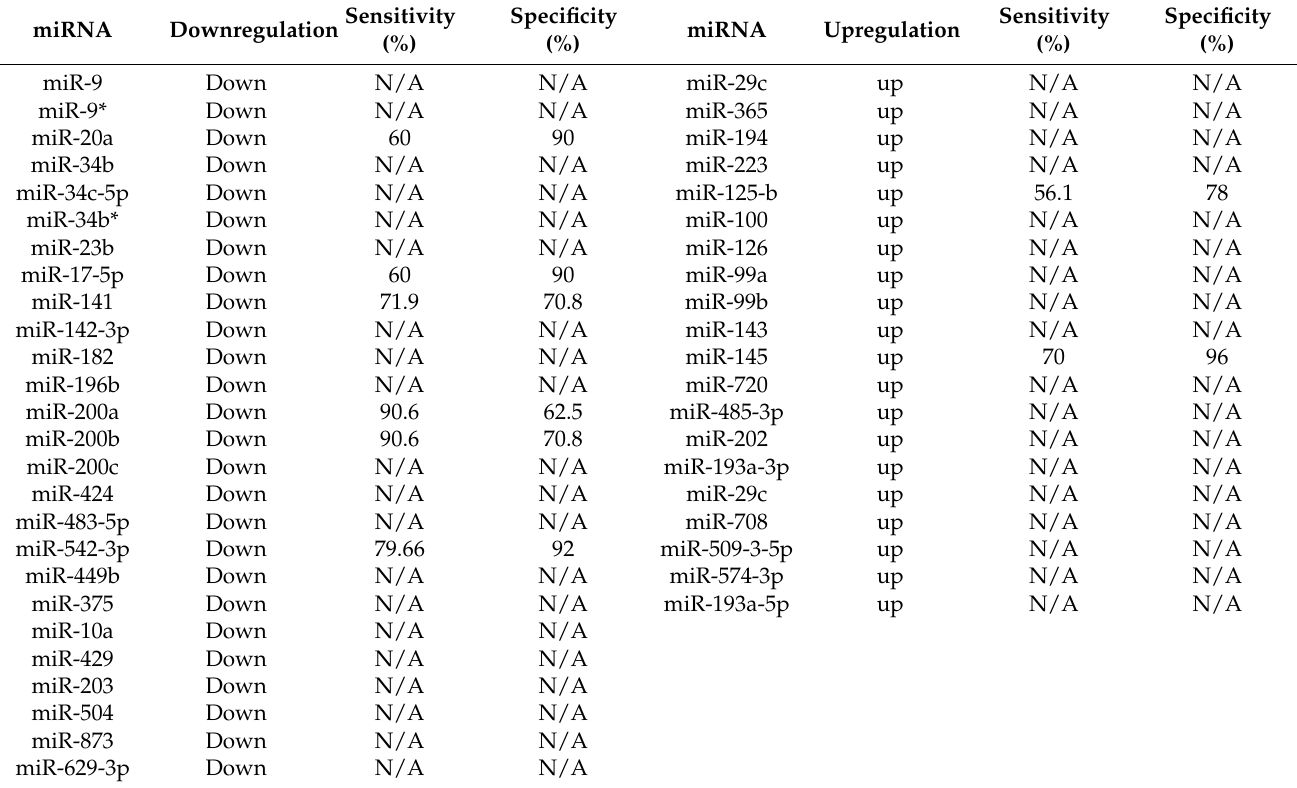
Table 1. Downregulation and upregulation of miRNAs expressed in different samples.